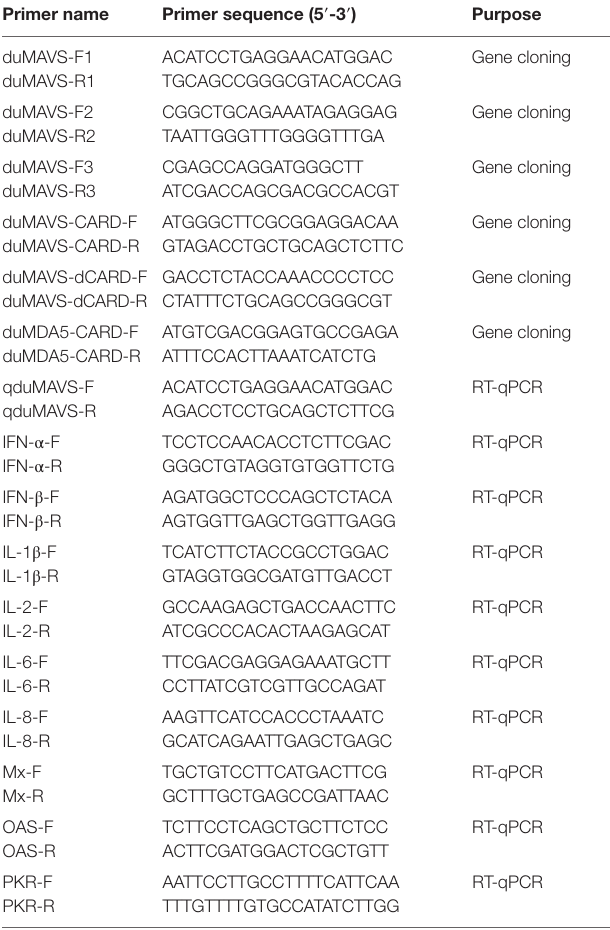
TaBle 1 | Primer sequences used in this